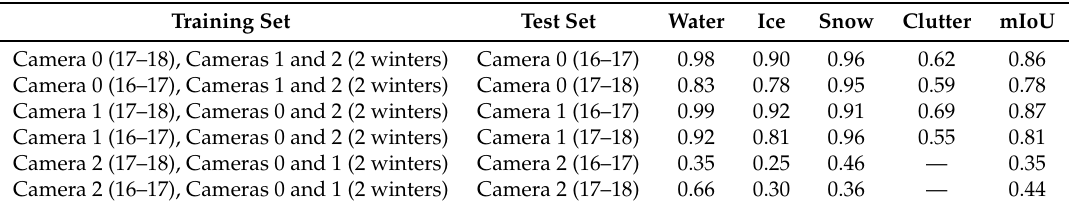
Table 20. Results (IoU) of leave one dataset out experiments. Cameras 0 and 1 monitor lake St. Moritz while camera 2 captures lake